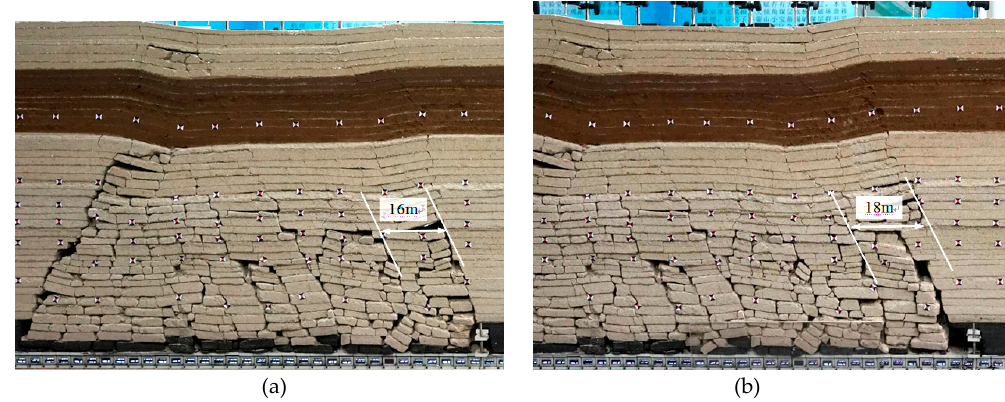
Figure 25. The main roof caving moment: (a) advanced to 114 m; (b) advanced to 132 m. This physical simulation, a total of 240 m of excavation working face is simulated (Figure 26).